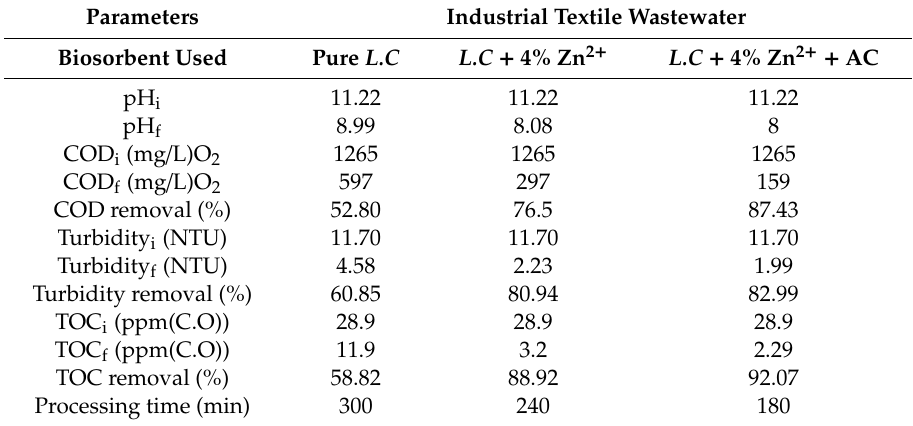
Table 6. Comparative results obtained for the purification of industrial textile